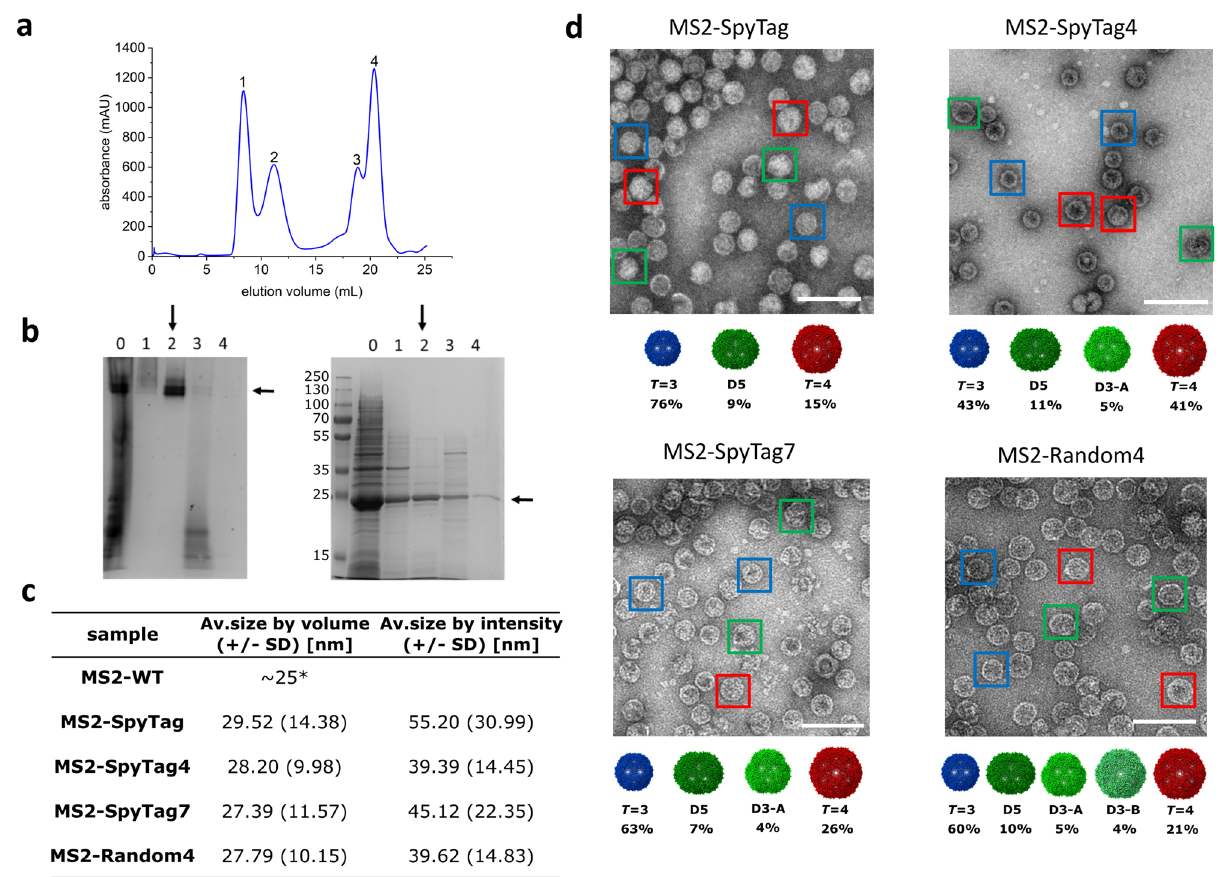
Fig. 2 MS2 VLPs puri fi cation and analysis. a A representative size exclusion puri fi cation pro fi le for an MS2 VLP; b native PAGE (left) and SDS-PAGE (right) analysis of eluted fractions: lane numbers correspond to peak numbers on the chromatogram; “ 0 ” denotes sample before SEC. Vertical arrows indicate fractions containing puri fi ed VLP and are used for further analysis. Horizontal arrows indicate bands corresponding to the expected molecular weight (of the coat protein dimer in SDS-PAGE and the VLP in native PAGE); c Table showing representative DLS measurements of hydrodynamic diameter of the MS2-SpyTag particles present in fractions collected from peak 2 (on the chromatogram). Volume distribution (top left) in comparison with the intensity distribution (top right); together with diameter measurements for the entire ensemble of MS2 samples, *adapted from ref. 53 d Transmission electron microscopy images of MS2 VLP variants. Color frames show different morphologies of the assembled VLPs: T = 3, T = 4 and the lower symmetry variants (D5, D3-A, and D3-B) in blue, red, and green, respectively with the overall percentage of each morphology identi fi ed in the analyzed samples; scale bar:100 ( Fig. 3c ) and inspected using transmission electron microscopy (TEM, Fig. 3d) with results demonstrating the integrity of the par- ticles as well as an increase in their volumes.